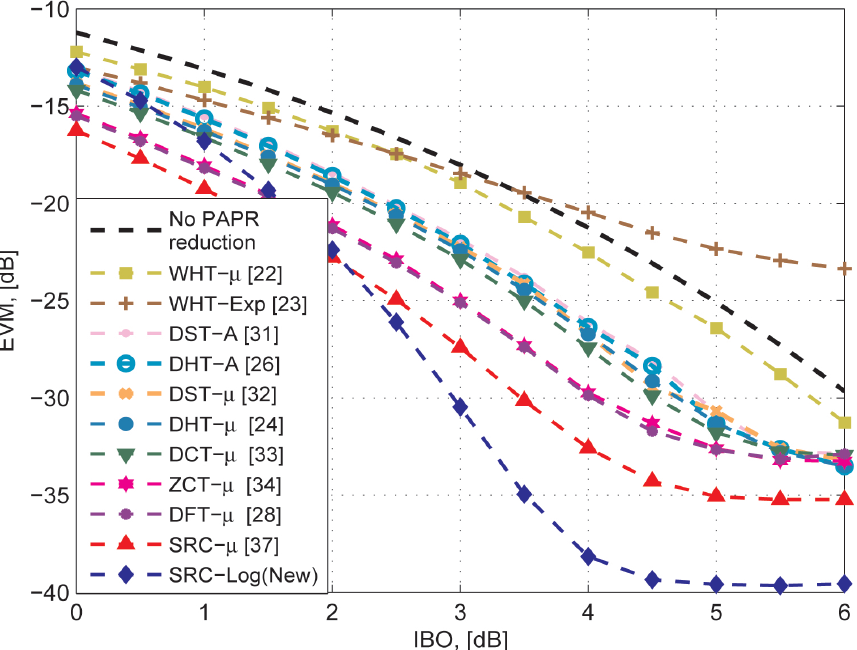
Figure 10. EVM comparison of the proposed SRC-Log and the previous precoding- companding techniques, in addition to the cases of OFDM w/o PAPR reduction in the presence of nonlinearity.